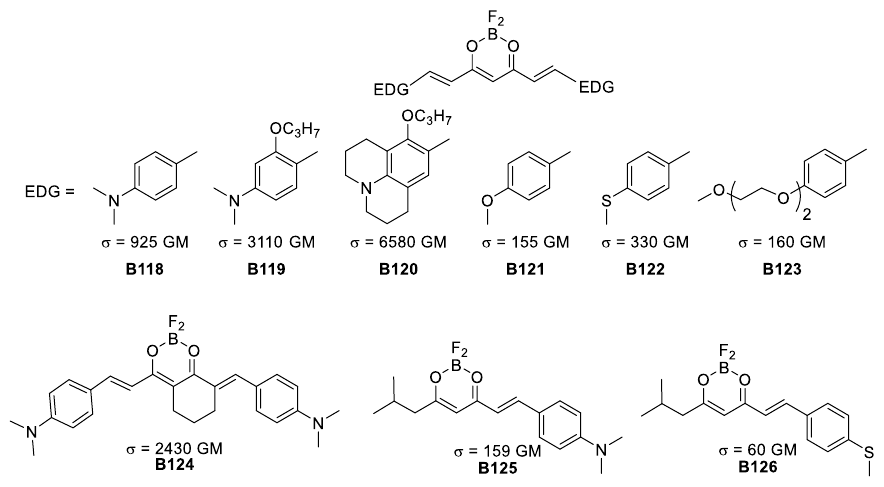
Figure 37. Quadrupolar BF 2 -coordinated hydroxyketones.